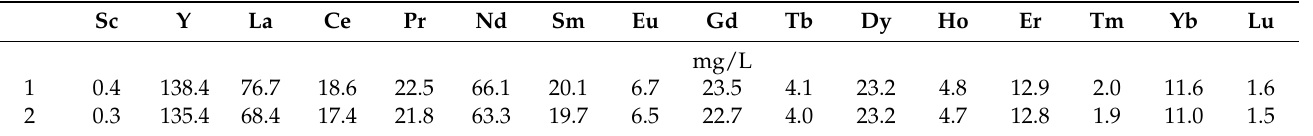
Figure 2. Secondary phases (celestite SrSO 4 ( a ) and gypsum CaSO 4 •2 Н 2 O ( b )) in the residues of the leachate. Most mineral particles after interaction with the HNO 3 solution were considerably changed and covered with a dense layer of redeposited leaching products. The exception was individual grains of aegirine, which retained their initial needle-prismatic habitus. In addition, the formation of secondary phases was not excluded. Apparently, they were represented by a thin mixture of silicate gels with various degrees of hydration, with cap- tured micron particles of acid-resistant minerals (egirine, loparite, feldspars), hydrolysis products of aluminum salts, as well as various ions of rare, alkaline, and alkaline earth elements